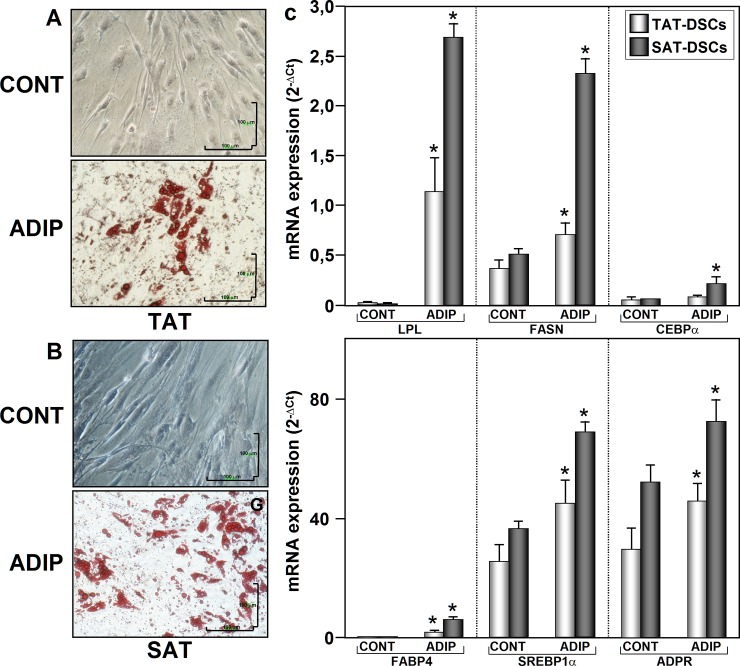
Adipogenic differentiation of human thymus and subcutaneous adipose tissues derived stromal cells (TAT-ASCs and SAT-ASCs).Representative photomicrographs of cells obtained from thymus fat (TAT-ASCs) (A) and from subcutaneous adipose tissue (SAT-ASCs) (B) (n = 26) grown in adipogenic medium for 14 days. Adipogenic differentiation of AASCs was confirmed by detecting the accumulation of the lipophilic marker, Oil Red O, over time in lipid droplets of adipose cells. (C) Adipogenic process confirmation was carried out by mRNA expression analysis of the adipogenic markers FABP4, LPL, FASN, ADRP, CEBPα and SREBP1α. mRNAs were normalized to cyclophilin expression levels. Each sample from each subject was analyzed separately and in triplicate. Data represent the mean ± SEM of the values obtained from all samples. The relation between control and adipogenic differentiation was analyzed by range test with Wilcoxon sign. *p<0.05. Image magnification is 20X.